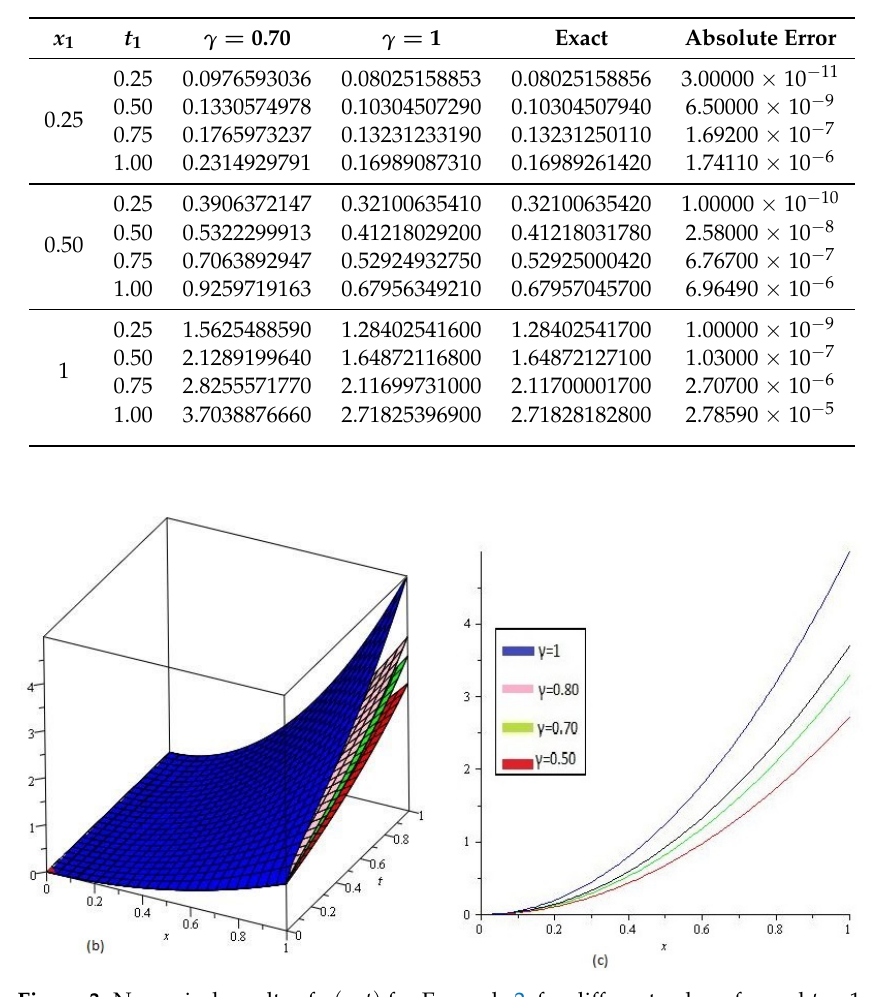
Figure 3. Numerical results of υ ( x , t ) for Example 2, for different value of γ and t = 1.